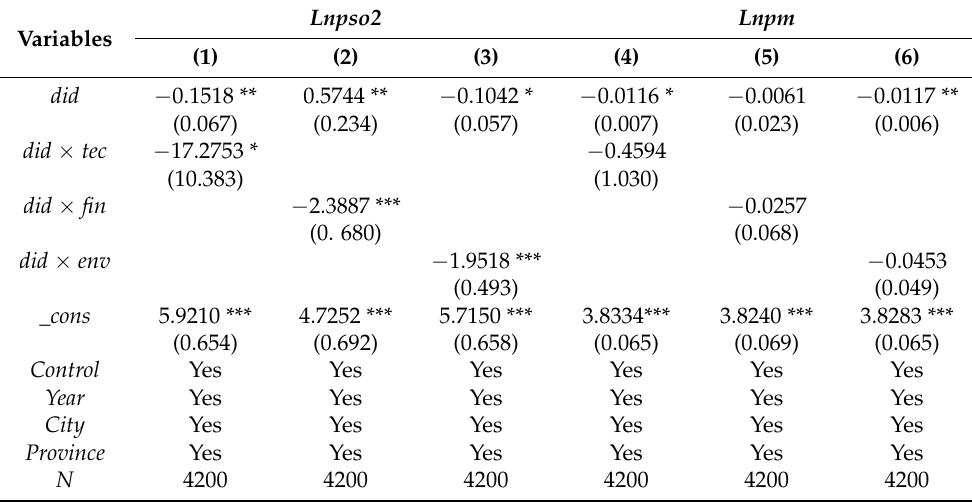
Table 8. Tests of moderating effects of government